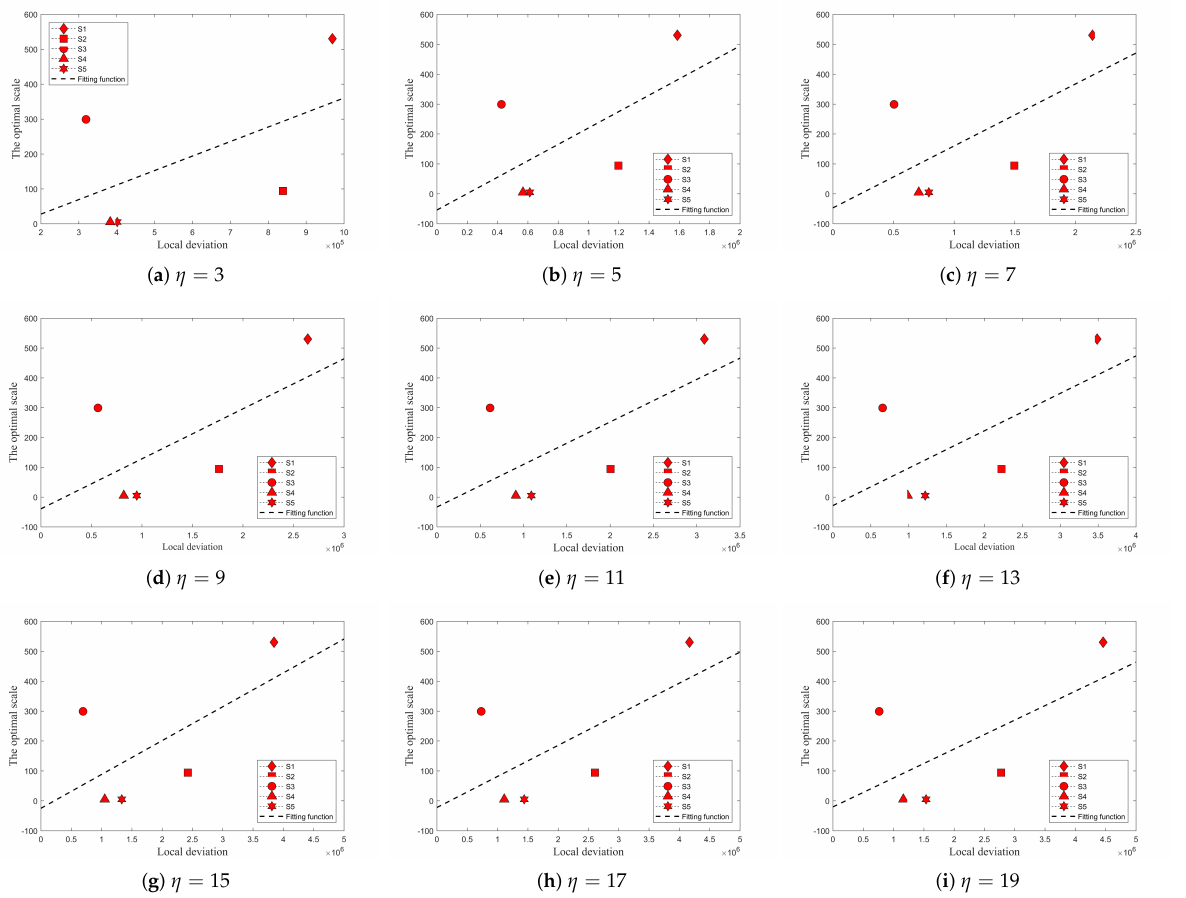
Figure 13. The relationship between the scale and corresponding local variance of regions marked by NDVI for subset images of S1, S2, S3, S4, and S5 under different weighted neighborhood sizes η from the interval of [3,